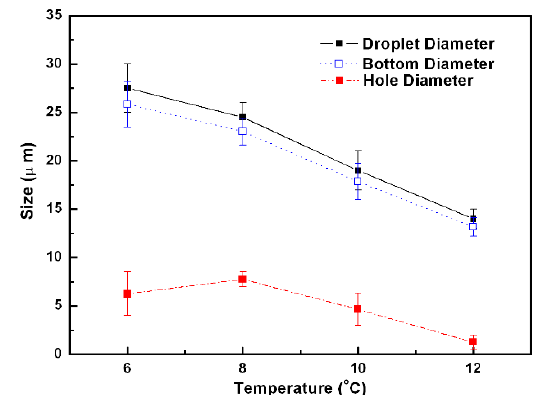
Figure 15. Comparisons among droplet diameters, bottom diameters of droplets, and fabricated hole diameters, with the substrate temperature ranging from 6 ∘ C to 12 ∘ C.